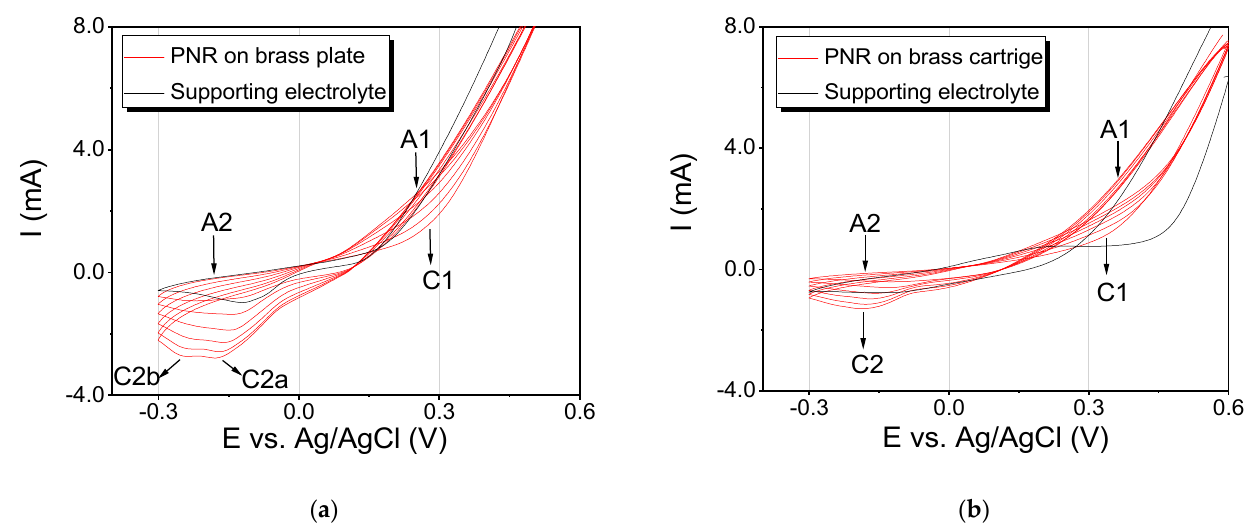
Figure 2. Cyclic voltammogram of the deposition of a PNR layer on the applied fingerprint on ( a ) a brass plate and on ( b ) a brass cartridge. Black curve, supporting electrolyte (0.1 mol ∙ L − 1 NaNO 3 ); red curve, polymerization of 0.002 mol ∙ L − 1 of NR. The potential range of polymerization was from − 300 to 600 mV (SR 50 mV ∙ s − 1 , 6 cycles).